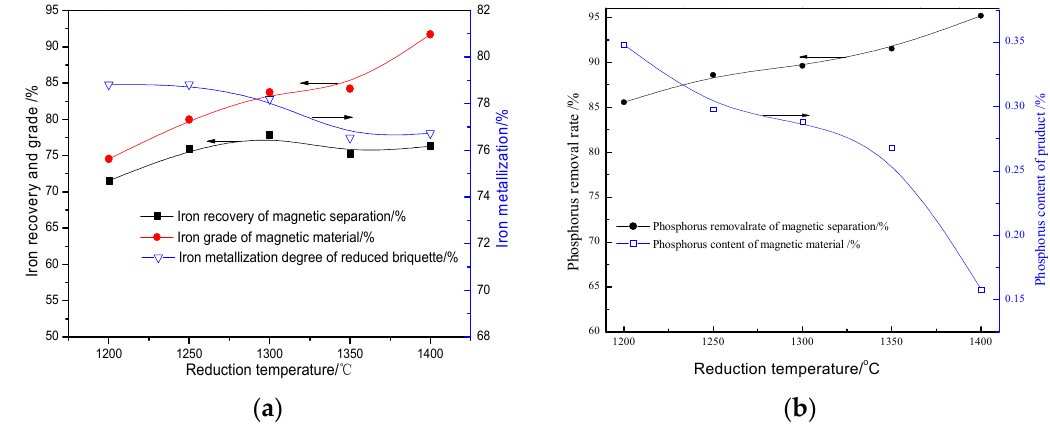
Figure 7. Effects of reduction temperature on beneficiation of iron and phosphorus removal (2.4 basicity, ore blended with 10% sodium sulfate and reducing for 15 min with C/Fe = 0.48). ( a ) Effect of temperature on iron recovery; ( b ) effect of temperature on phosphorus removal.